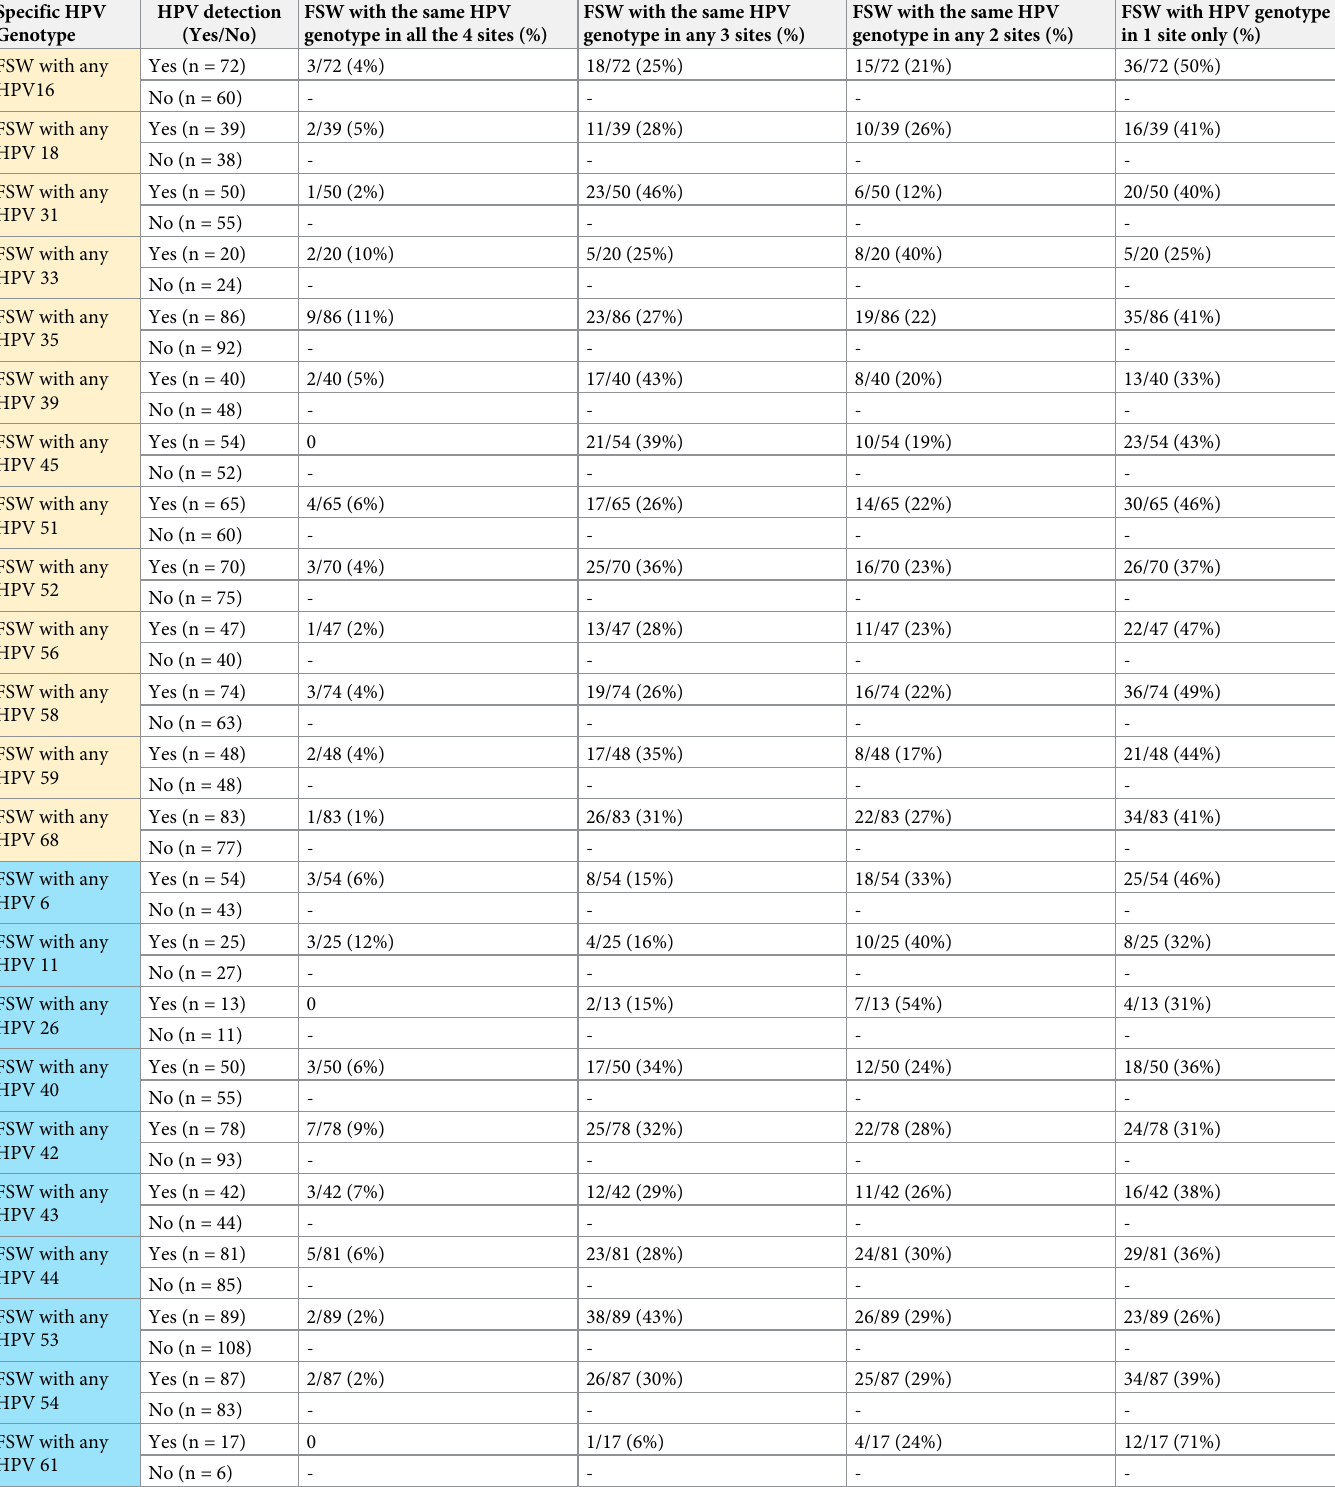
Table 5. Proportion of HPV genotype specific concordance samples across the four anatomic sites of cervix, vulvar, anal and oral cavities among brothel-based female sex workers in Ibadan, Nigeria. Specific HPV